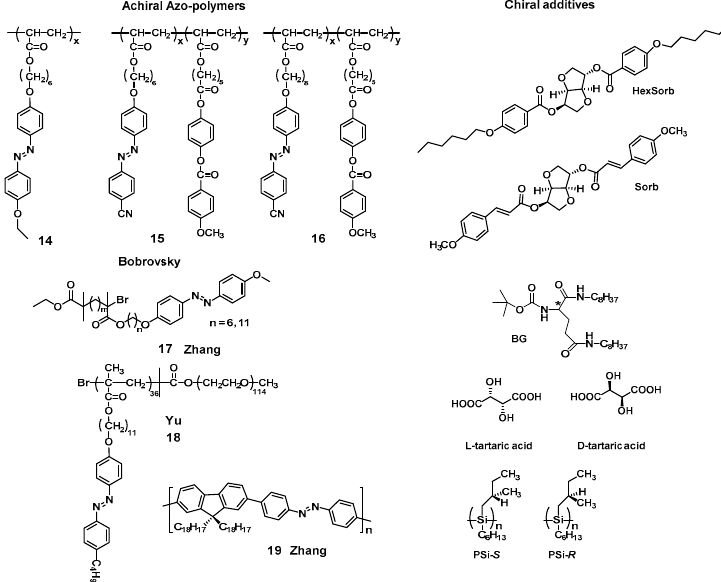
Figure 8. The chemical structures of achiral Azo-polymers 14, 15, 16, 17, 18, 19 and chiral